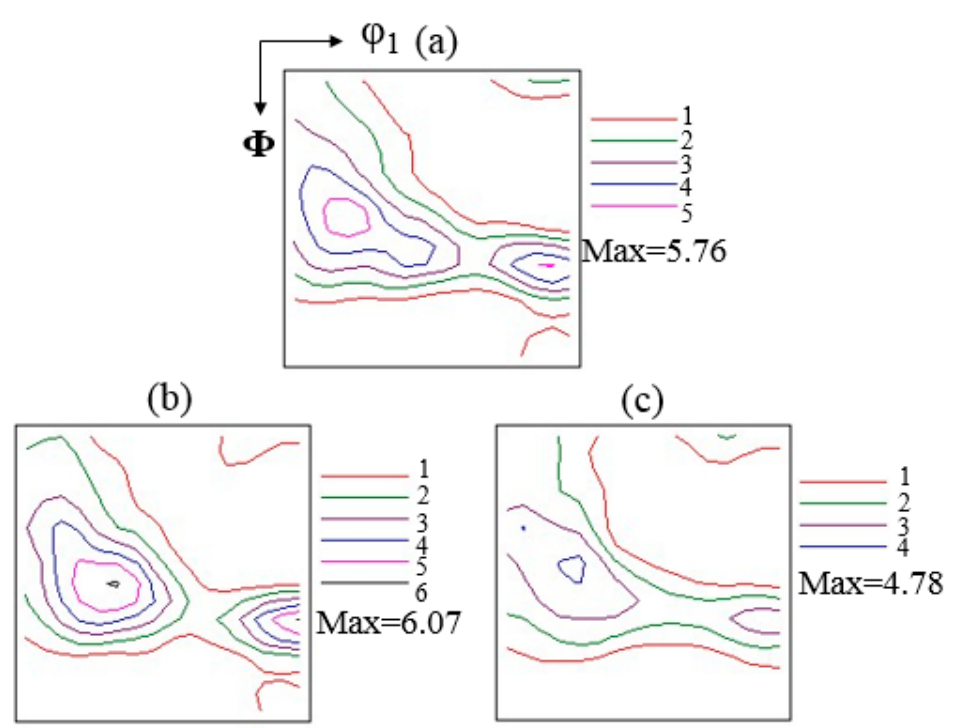
Figure 9. Texture ( φ 2 = 45 ◦ ODF section) of decarburized specimens normalizing annealed at 920 ◦ C ( a ), 950 ◦ C ( b ), 980 ◦ C ( c ).